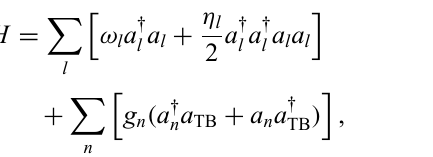
qubit-subspace, notation | Q